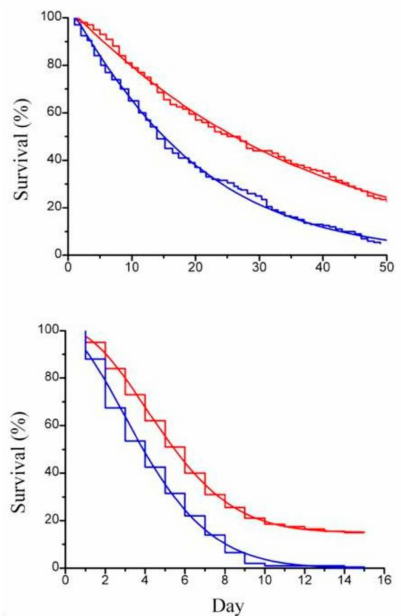
Figure4. ( a )Survivalcurve(stepline)of Artemia sp.; ( b )survivalcurve(stepline)of Artemia sp. o ff spring with the corresponding Weibull survival functions (continuous line), with paramylon (red curve) and without paramylon (blue curve), under conditions of no daily medium replacement.